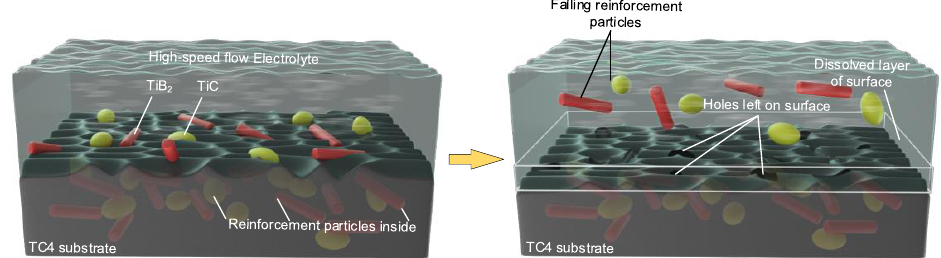
Figure 14. Electrochemical dissolution and removal mechanism of (TiB+TiC)/TC4 composite .